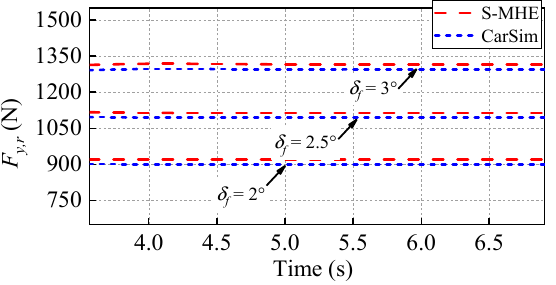
Figure 13. A partially enlarged view of rear lateral tire force.